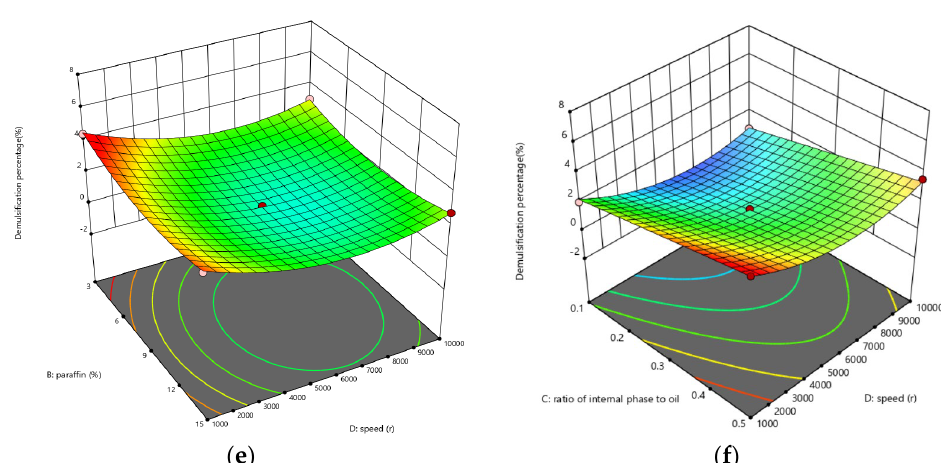
Figure 4. ( a ) Concentration of Span-80 and liquid paraffin; ( b ) concentration of Span–80, ratio of internal phase to oil; ( c ) concentration of Span-80, rotational speed of homogenizer; ( d )concentration of liquid paraffin, ratio of internal phase to oil; ( e ) concentration of liquid paraffin, rotational speed of homogenizer; ( f ) ratio of internal phase to oi, rotational speed of homogenizer.